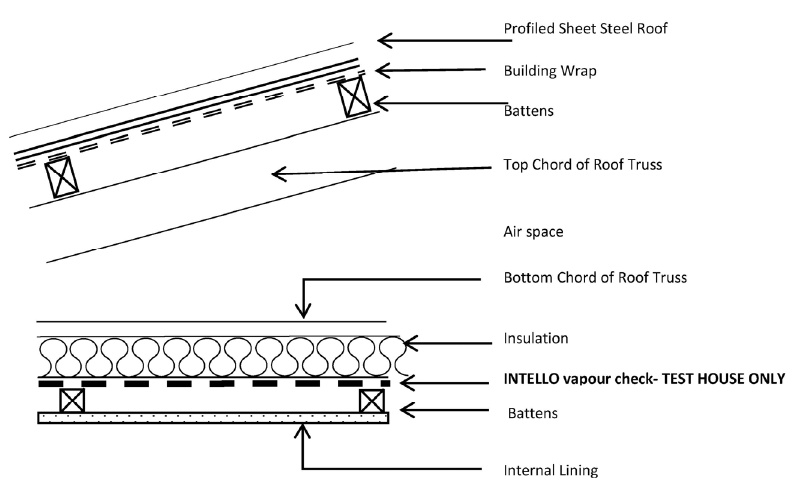
Figure 5. Construction detail—external walls.